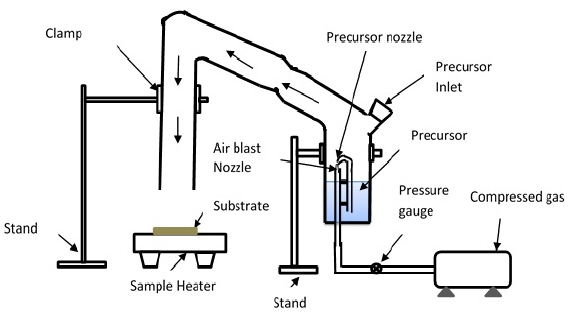
Figure 1. Spray pyrolysis experimental set up.